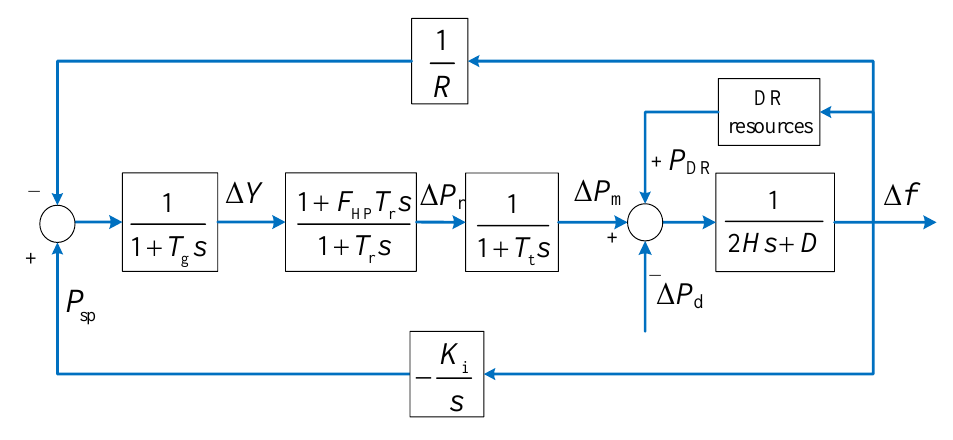
Figure 1. Frequency response model with DR.